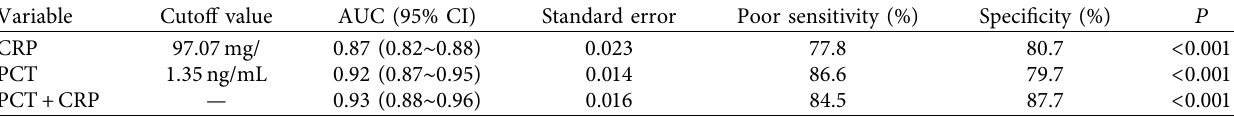
Table 9: Diagnostic value of CRP, PCT and CRP +PCT tandem for